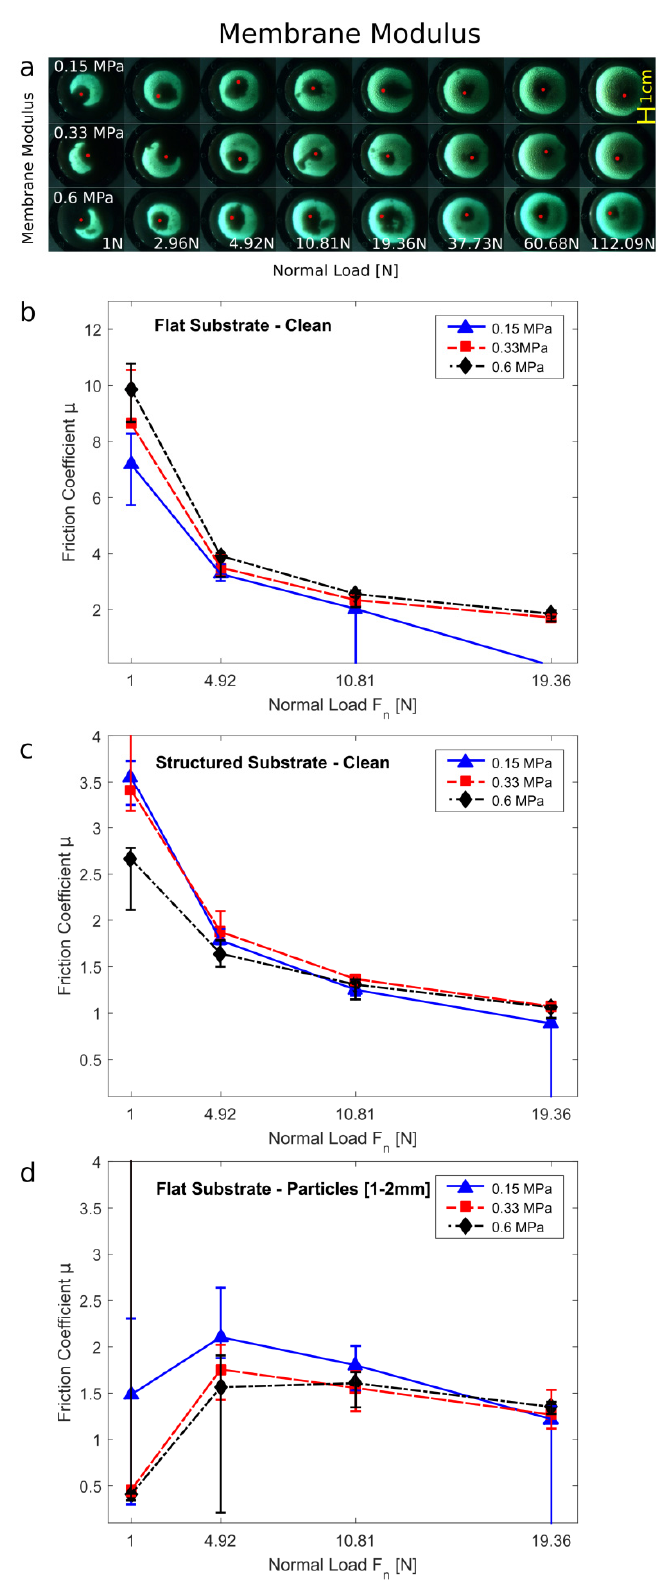
Figure 3. Variation of the membrane modulus of the granular friction pad. ( a ) Visualization of the contact area on a glass sphere and smooth glass substrate. ( b – d ) Friction coefficient of the samples at different normal loads F n : ( b ) on a smooth substrate, ( c ) on a rough/structured substrate, ( d ) on a smooth substrate contaminated by 1–2 mm large particles.